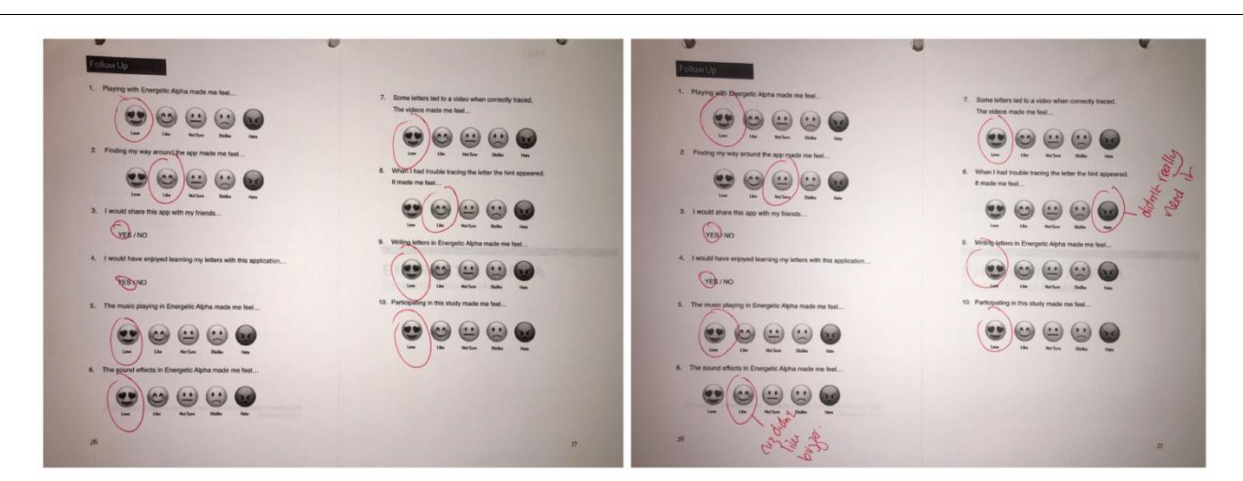
FIGURE 7 | Final page of the task booklet Apple Color Emoji